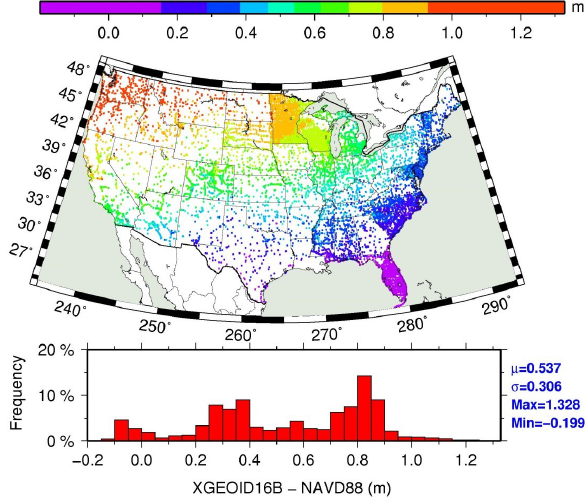
Figure 1: The geoid differences between the newest experimental geoid model, xGeoid16B, and the NAVD 88 orthometric height im- plied geoid heights at 21,112 GPS/Leveling benchmarks over the target